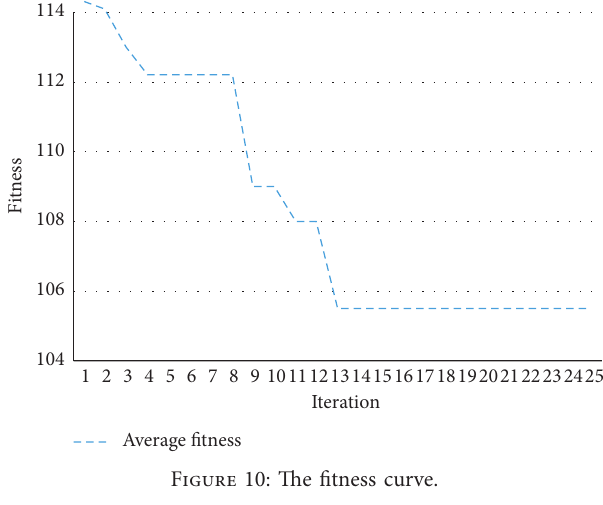
Figure 10: The fitness